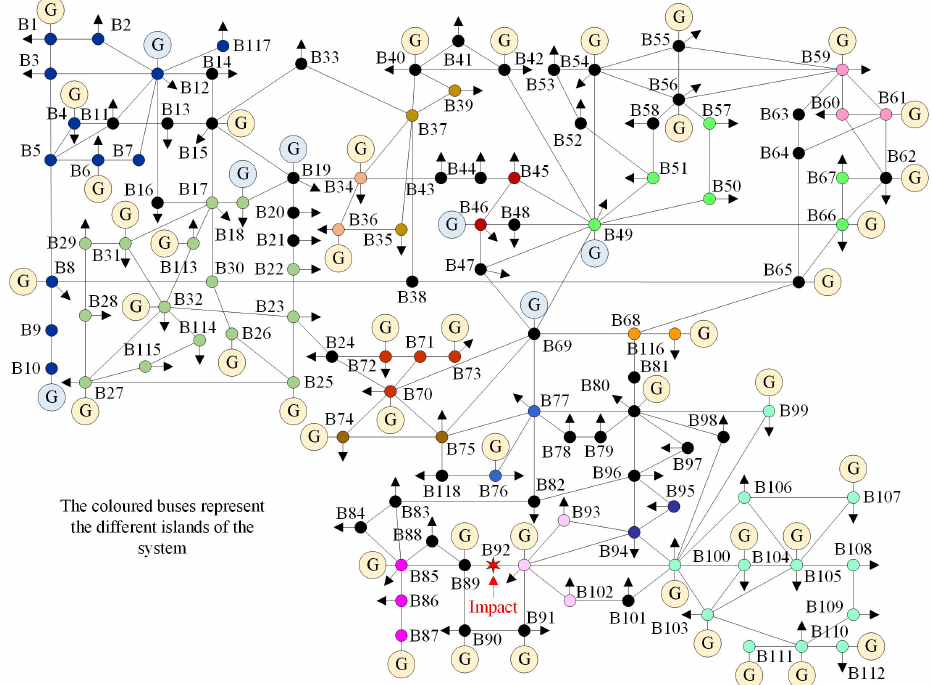
Figure 7. Schematic representation of the power system under study after the cascading failures took place.